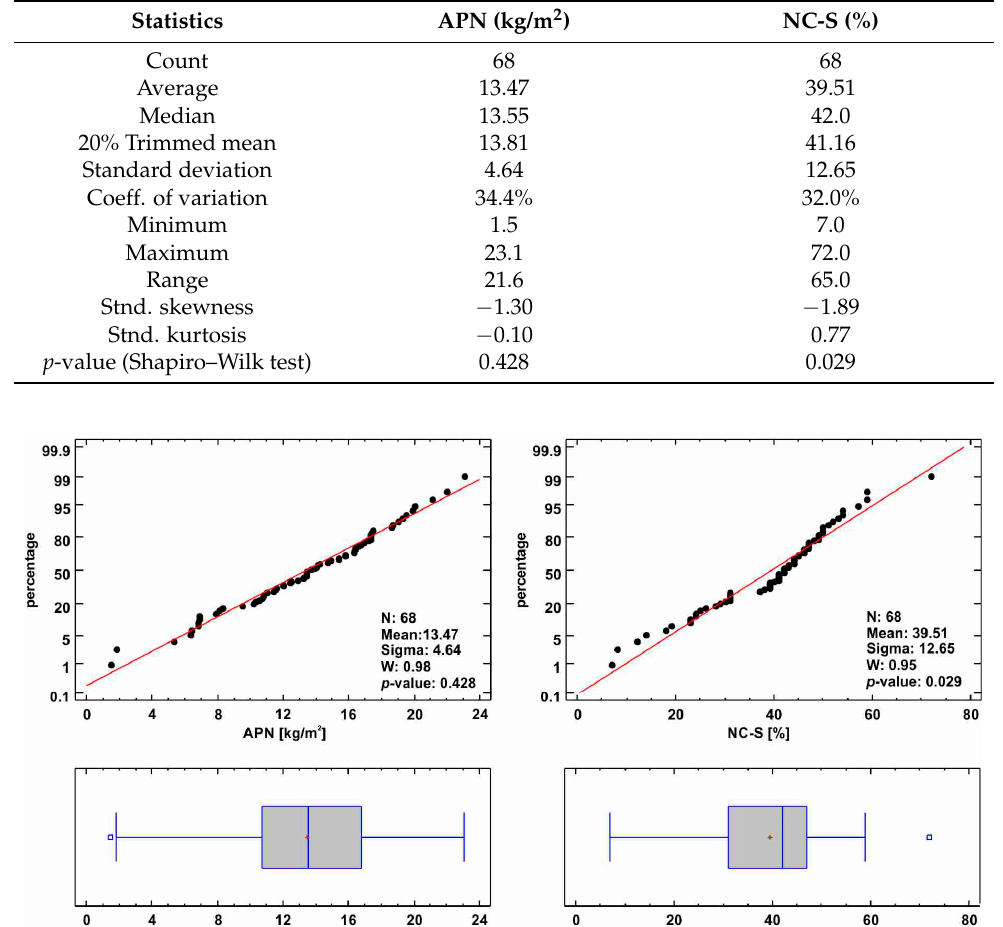
Table 1. Statistics of the nodule abundance (APN) in the box core and the percentage of seafloor nodule coverage (NC-S) determined from the photographs.